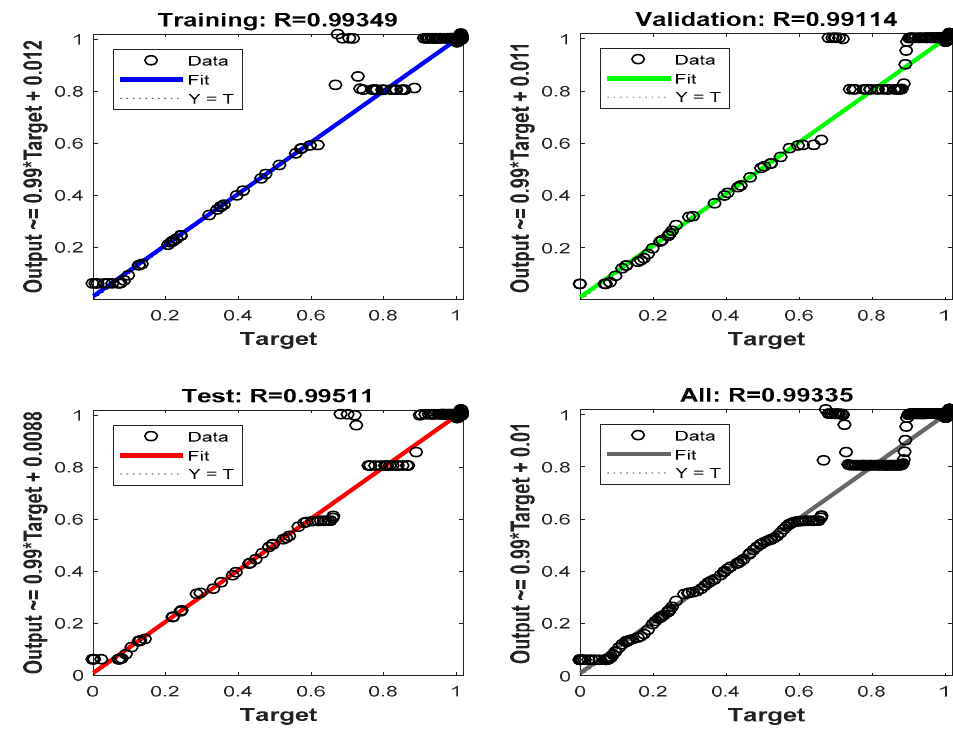
Figure 27. Results of self-tuning fuzzy-PID after NN optimization.